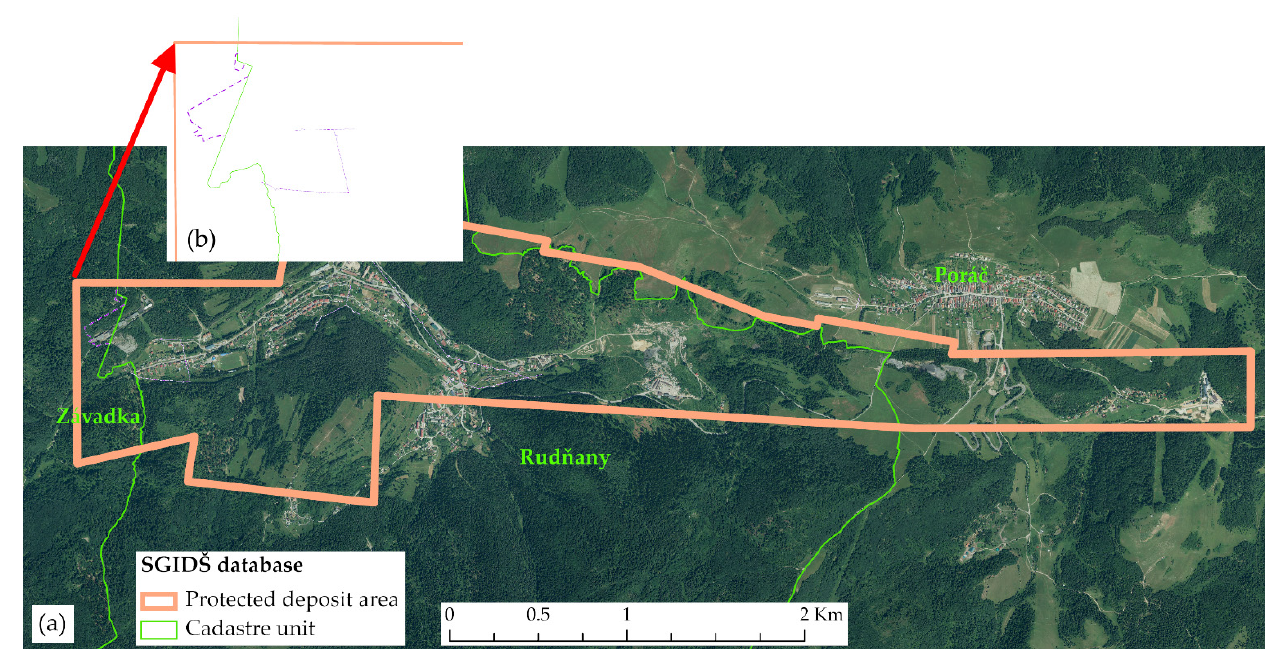
Figure 8. Protected deposit area Rudˇnany: ( a ) PDA boundary within three cadastral units; ( b ) Detail of the representation of the inconsistency of the registered PDA boundary.